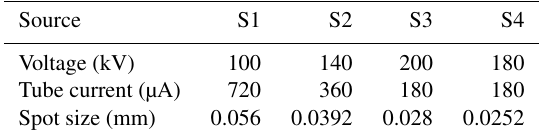
Table 1. XCT system scanning parameters used.